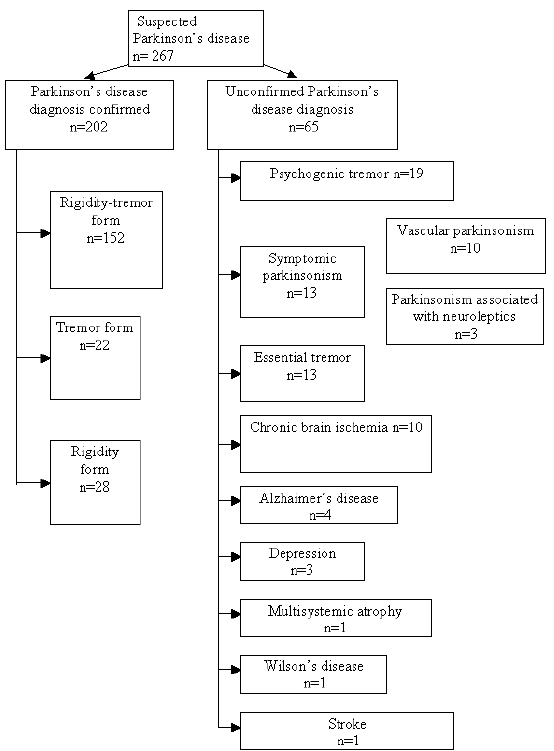
Figure 1. Diseases diagnosed for the patients with unconfirmed Parkinson’s disease and disease clinical